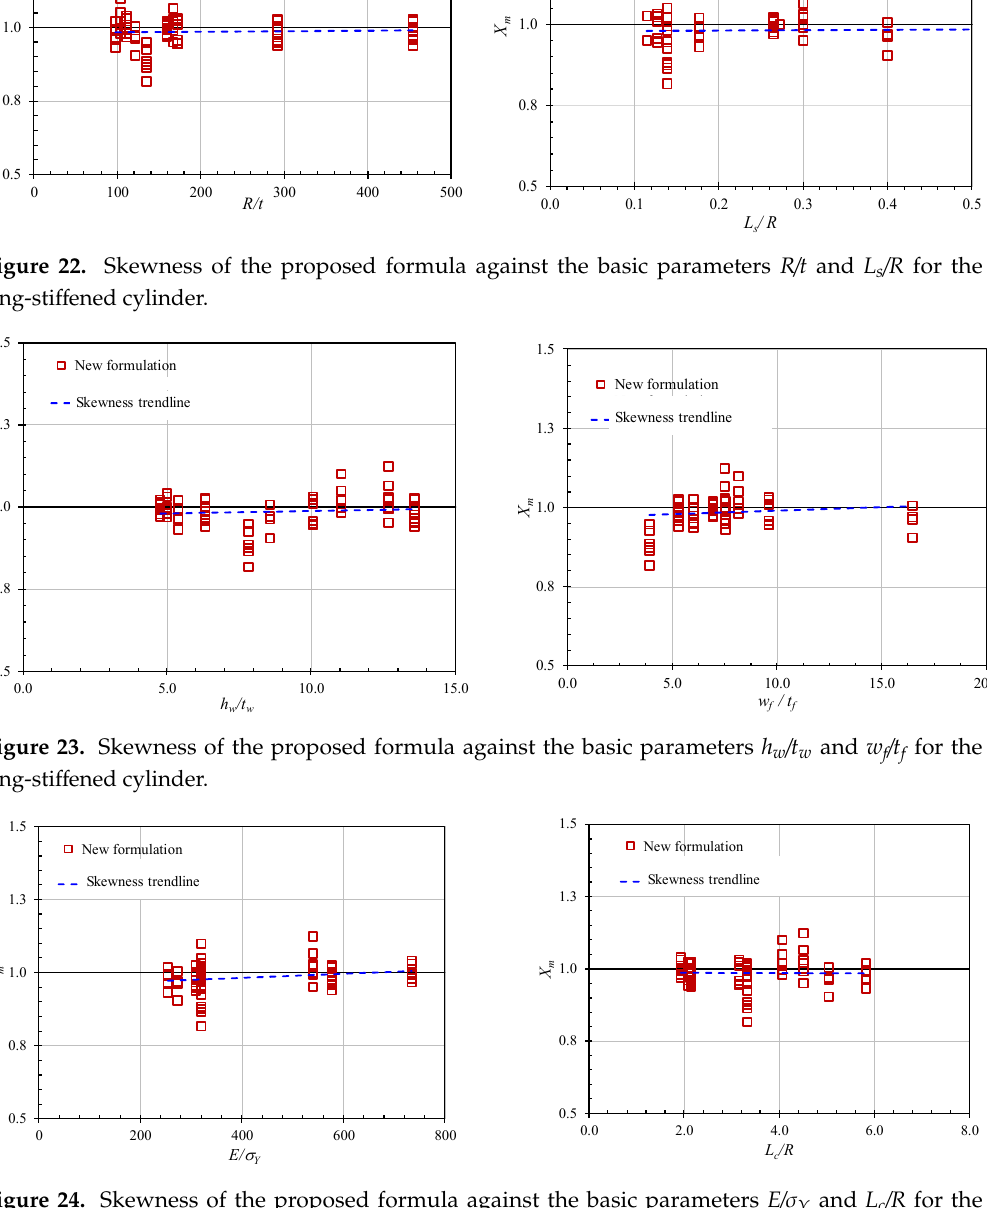
Figure 24. Skewness of the proposed formula against the basic parameters E/σ Y and L c /R for the ring- stiffened cylinder.